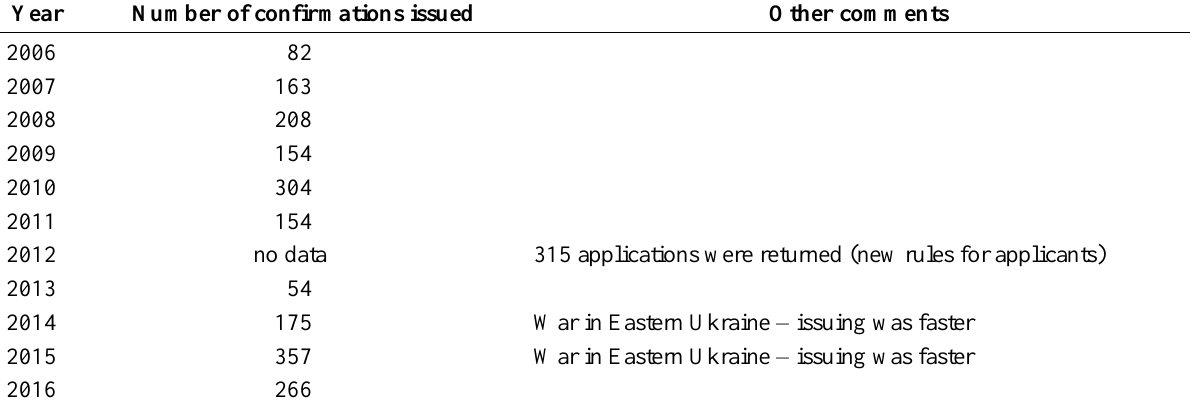
Table 4. Confirmations of belonging to the Czech diasporic community abroad